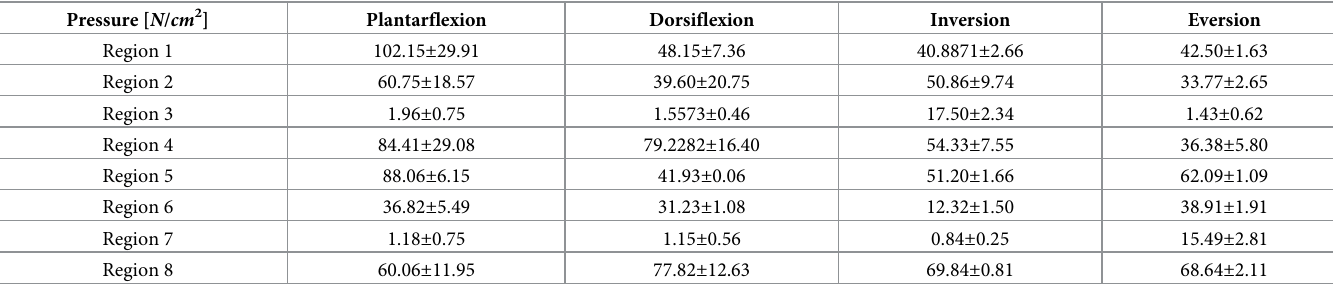
Table 5. Experimental evaluation of the upper platform under dynamic